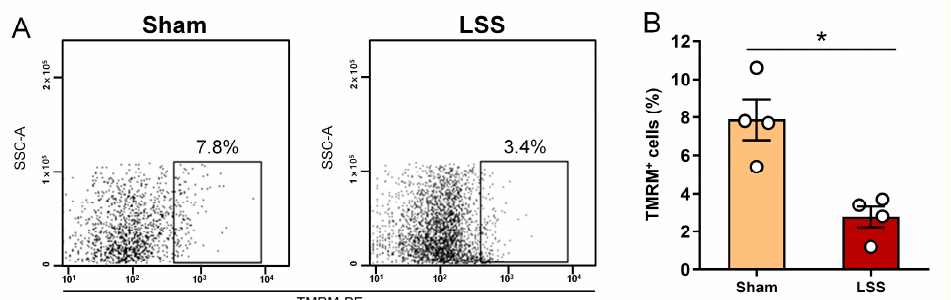
Figure 5. Assessment of MMP within CSF after given LSS. ( A ) Representative flow cytometry dot blot of the TMRM in sham and LSS models using the FSC parameters. ( B ) Flow cytometric quantification of TMRM within the CSF in sham and LSS models. Data are expressed as the means ± SEM. Significant differences indicated as * p < 0.05 vs. the sham group were analyzed via unpaired t test with Welch’s